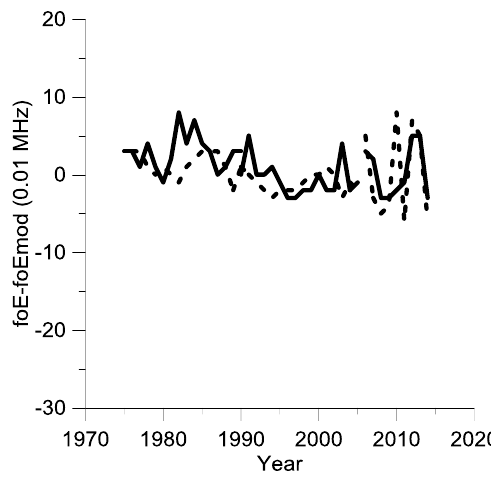
Figure 2. Residuals (cid:49) fo E (0.01MHz) after removal of solar activity (F10.7) influence (Eq. 1) separately for the three sub-periods 1975– 1990, 1990–2005, and 2005–2006, yearly values, for Chilton (full line) and Juliusruh (dashed